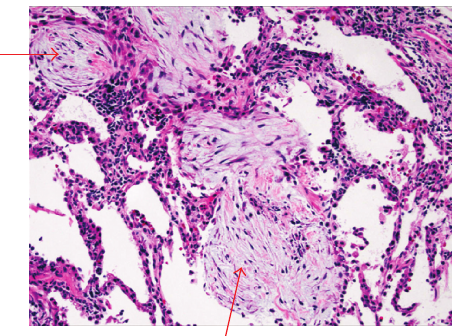
Figure 3: Hematoxylin & eosin stain demonstrating the hallmark intra-alveolar buds of granulation tissue that are characteristic of organizing pneumonia.